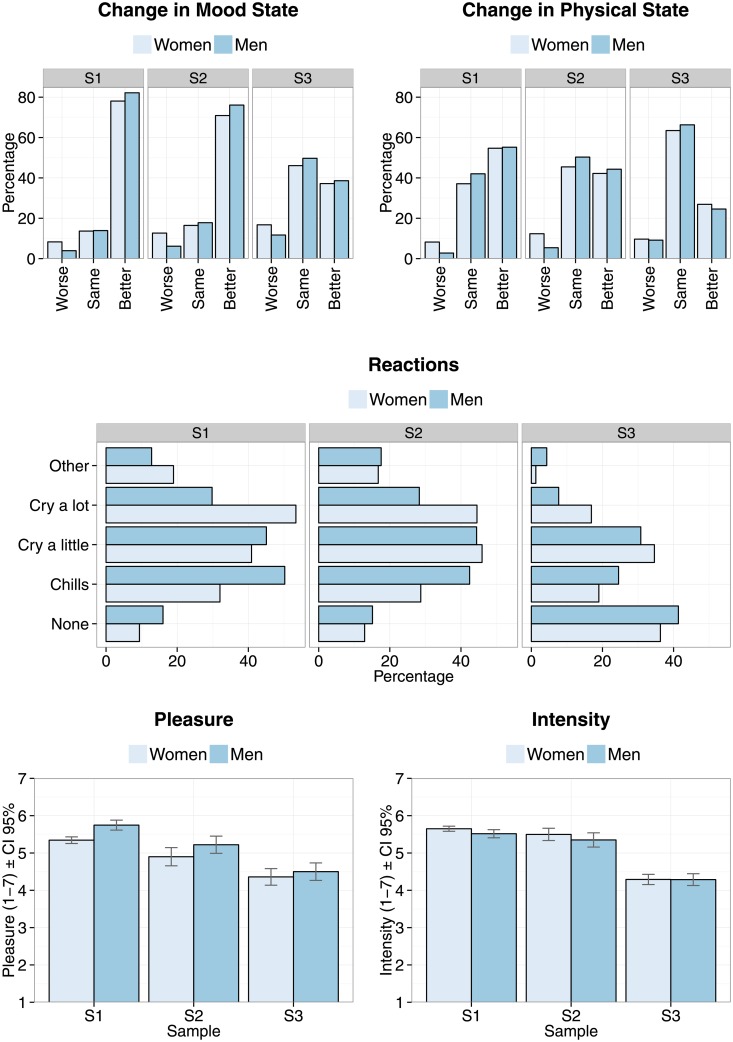
Percentage of participants indicating physical or mental reactions, changes to states, and pleasure and intensity related to memorable sad music episodes across samples and gender.